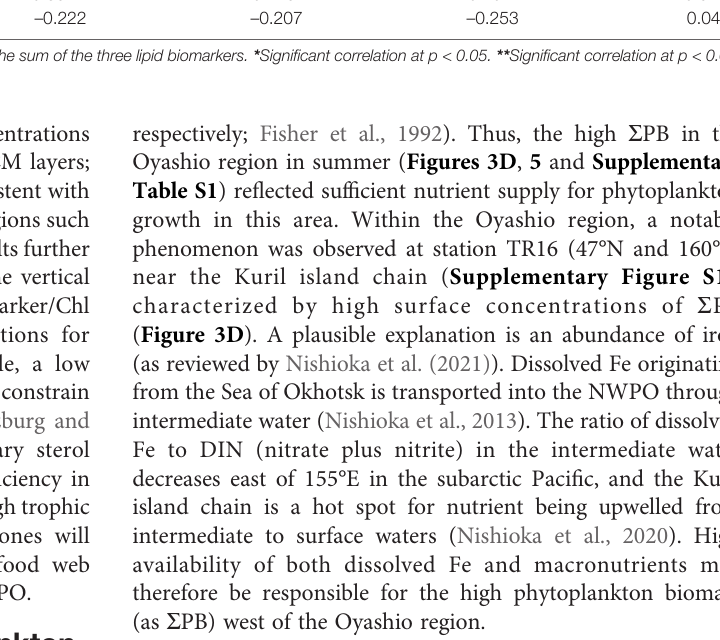
Table S1 ) re fl ected suf fi cient nutrient supply for phytoplankton